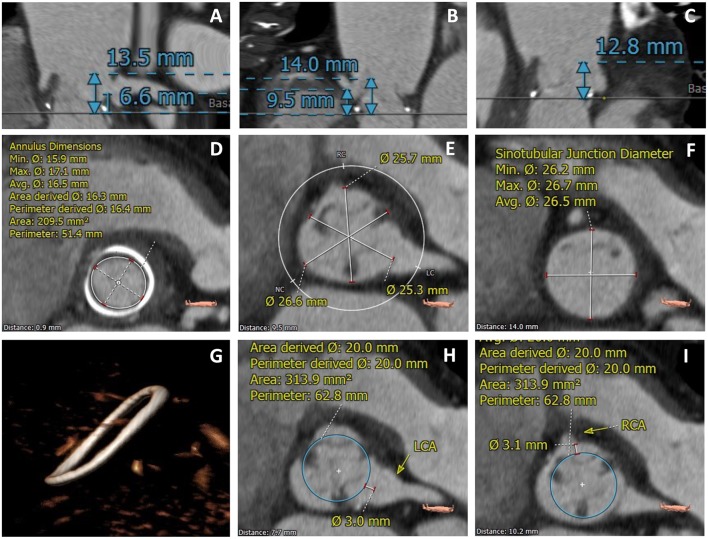
MSCT evaluation of a TAVR VIV case with high-risk features for coronary obstruction. (A) Left coronary height to the valve plane of 6.6 mm; (B) Right coronary height to the valve plane of 9.5 mm; (C) Low STJ; (D) Measurement of the SHV internal diameter; (E) Measurement of the SOV diameters; (F) Measurement of the STJ diameters; (G) Identification of SHV (Medtronic Hancock Standard); (H,I) VTC value <4.0 mm for both left and right coronary arteries.